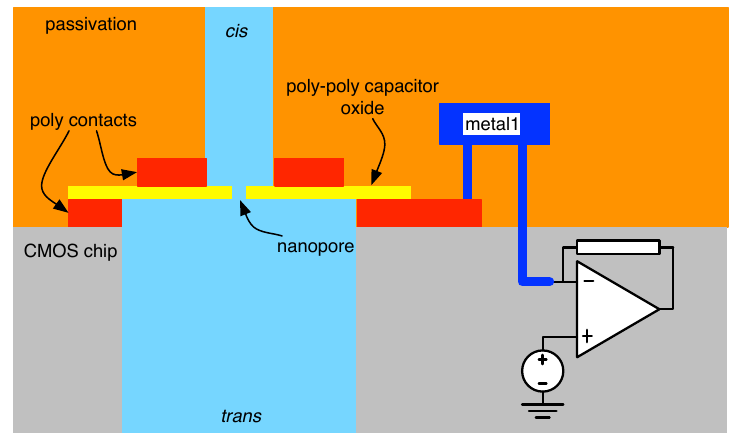
Figure 21. Direct implementation of a nanopore in an active CMOS